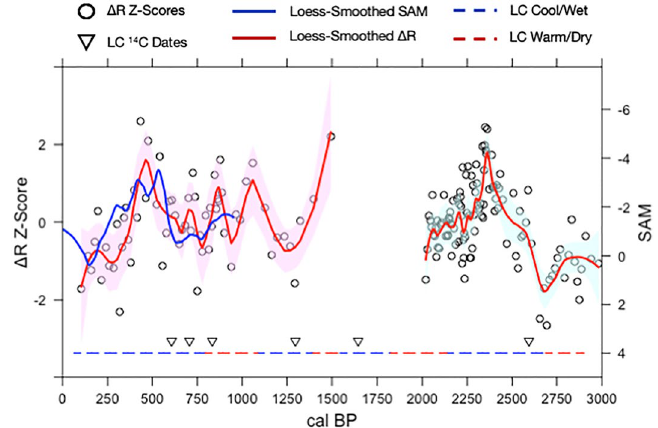
Figure 4. Subtropical SPG ∆R Variability and Paleo-SAM over the Late Holocene. Loess filtered proxy data (Abram et al. 39 Paleo-SAM—blue; Z-Score normalized ∆R—red) overlaid on top of Z-Score normalized ∆R data (black open circles). Loess filtering uses a λ of 0.2. Light red shading shows a confidence interval of 95%. ∆R data older than 950 cal BP is used as a proxy record to infer SAM conditions over the late Holocene. Red and blue dashed lines represent the inferred cool/wet and warm/dry periods from Ciprese Cycles (CC#) in Patagonia, South America 40 complete with radiocarbon dates for the LCNAP record (inverted white triangles with black outline). The and the correlation between loess-filtered paleo-SAM and a z-score normalization of the 64344 ∆R record is r = − 0.54 ( p < 0.01; n =